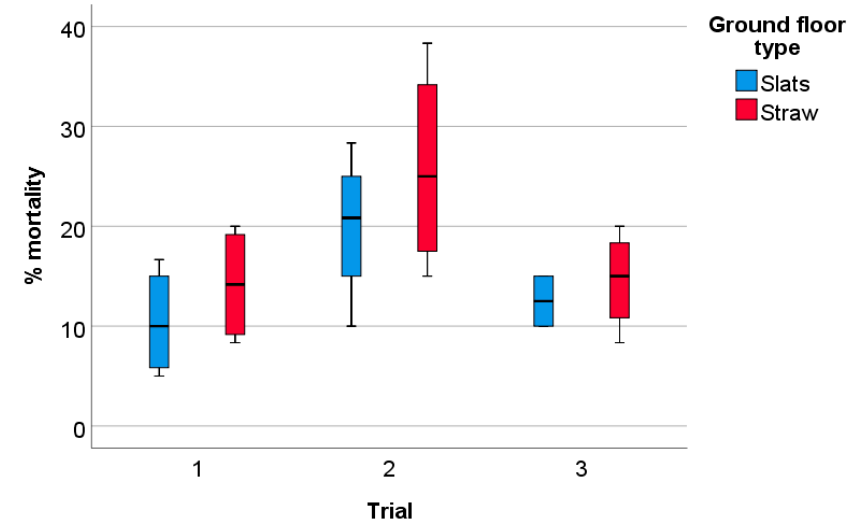
Figure 7. Mortality at pen level according to ground floor type and trial. Slats: pens with ground floor consisting of slatted plastic panels, n = 4 per trial; Straw: pens with the ground floor consisting of concrete littered, n = 4 per trial.